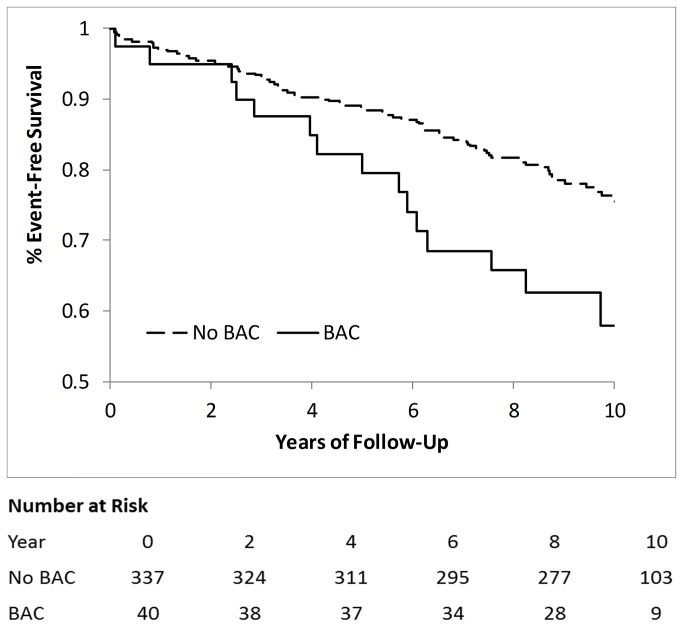
Freedom from Major Cardiovascular Events by Presence vs. Absence of BAC.